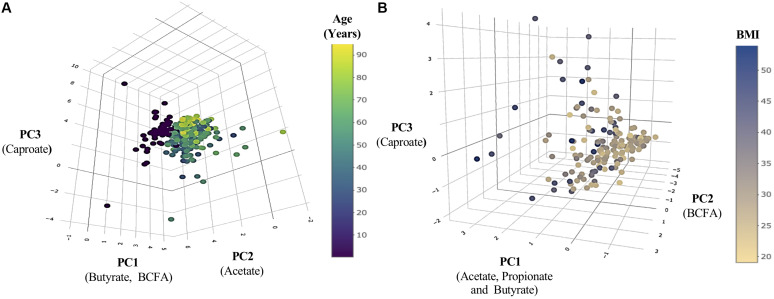
Population distribution regarding changes in SCFA production throughout life and BMI increases. (A) Principal component analysis (PCA) of SCFA production throughout life. (B) PCA of SCFA production according with the increase of BMI. The main components of each axis are indicated below them in parentheses.